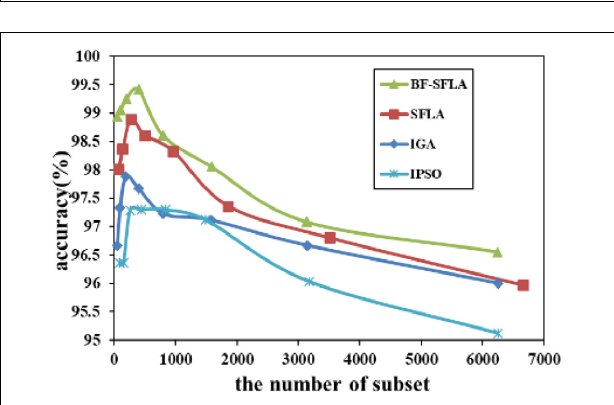
FIGURE 10 | The variation trend of classification accuracy and feature subset of